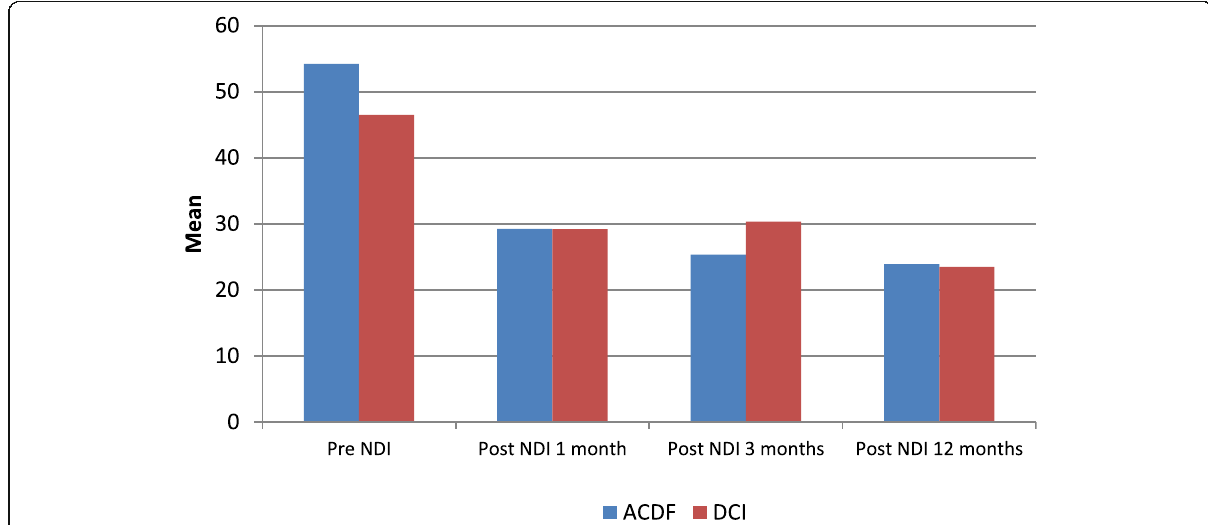
Fig. 3 Neck disability index recorded preoperatively and at 1, 3, and 12 months postoperatively for both